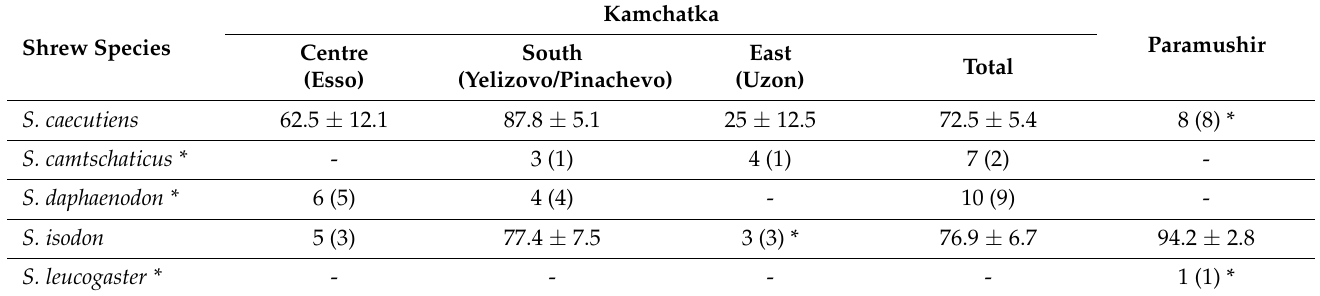
Table 3. The prevalence of shrews cestodes in Kamchatka and Paramushir (prevalence of infection and its standard error P ± SE, %); *—the small number of shrew specimens (the number of shrews with